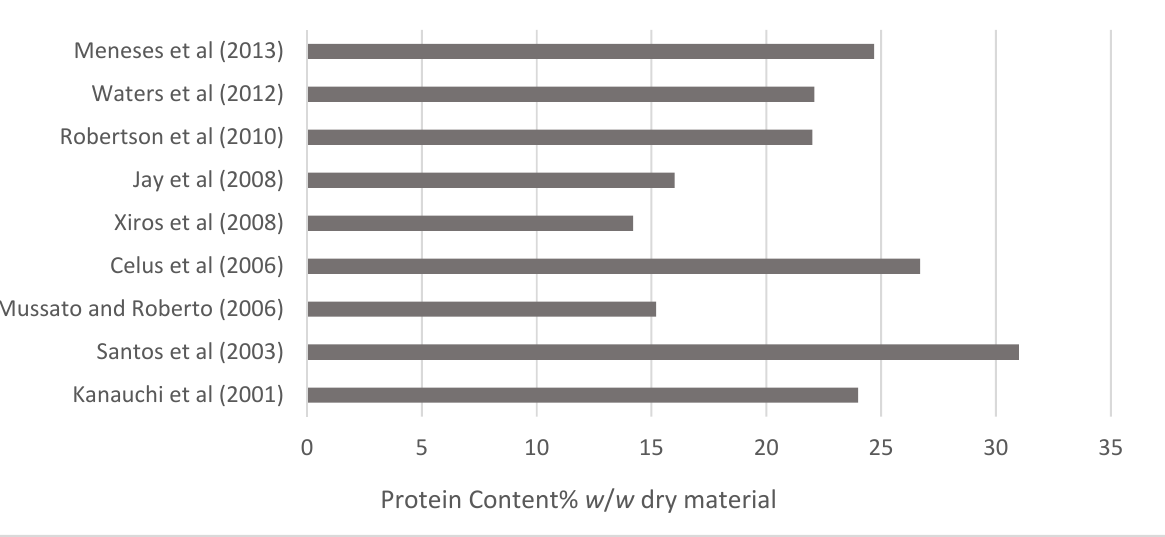
Figure 2. Protein content of brewers’ spent grain (BSG), % w / w dry matter [32,42–49] .